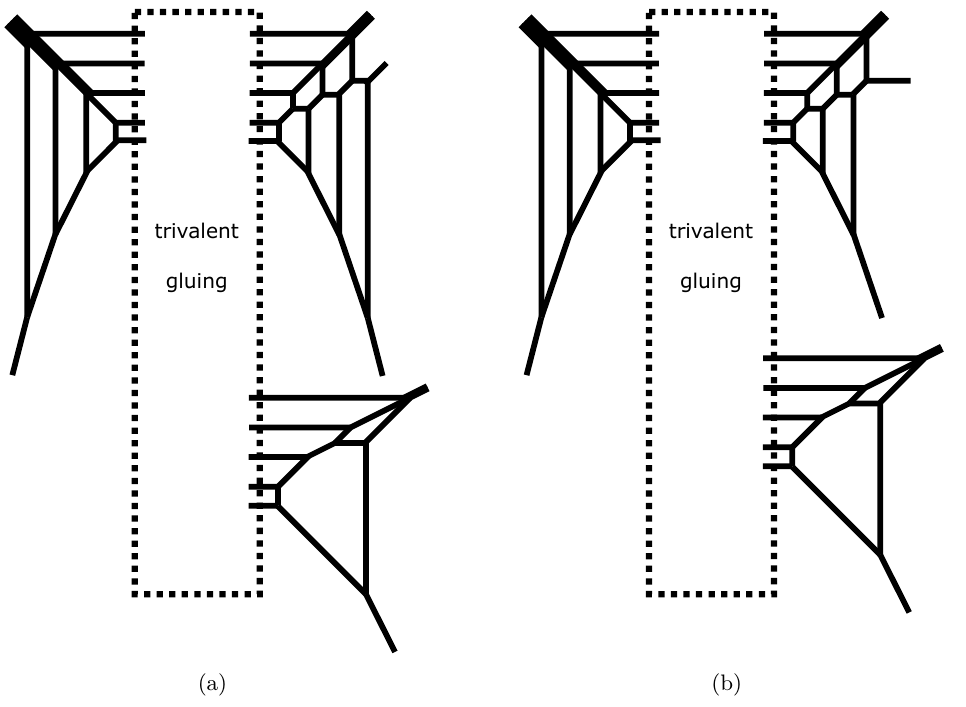
Figure 40. (a). The web diagram for the theory given by e (1) diagram for 5d E 7 gauge theory with one fundamental hypermultiplet and a fundamental half-